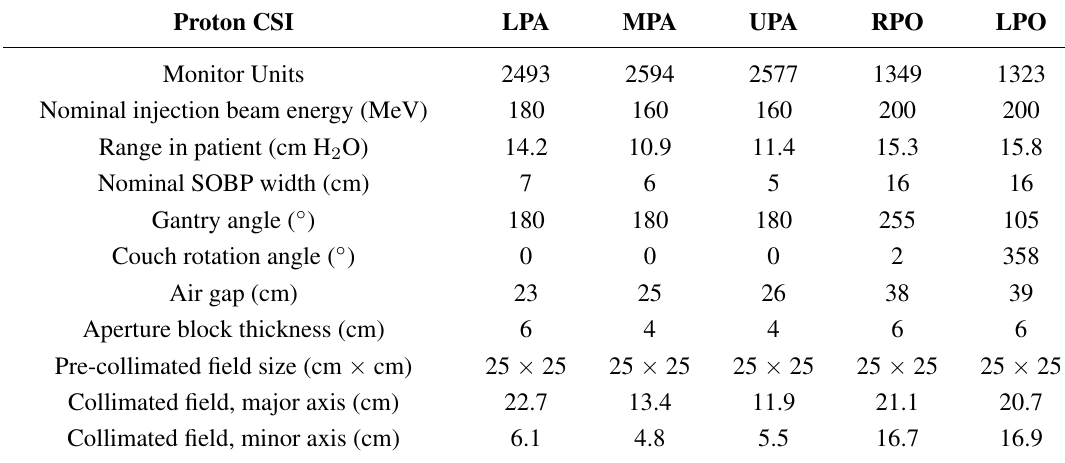
Abbreviations: LPA = lower posterior anterior; MPA = middle posterior anterior; UPA = upper posterior anterior; RPO = right posterior oblique; LPO = left posterior oblique; SOBP = spread-out Bragg